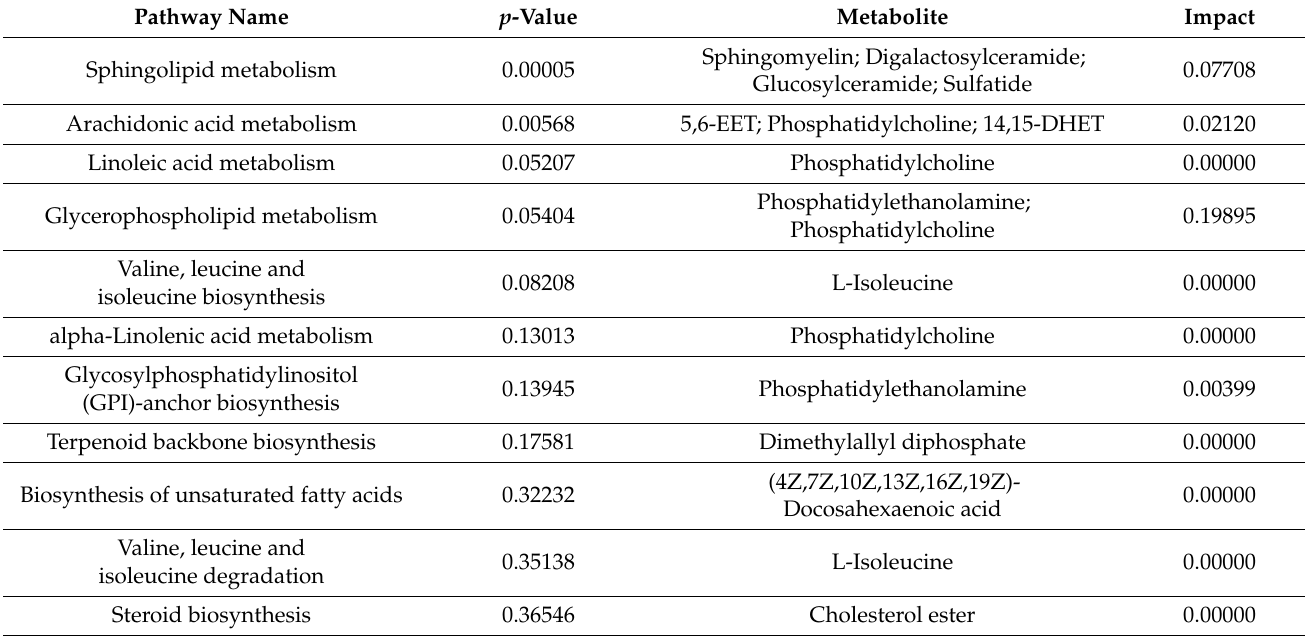
Table 1. The enriched KEGG pathway of differential metabolites of tMCAO/Sham in mouse plasma.